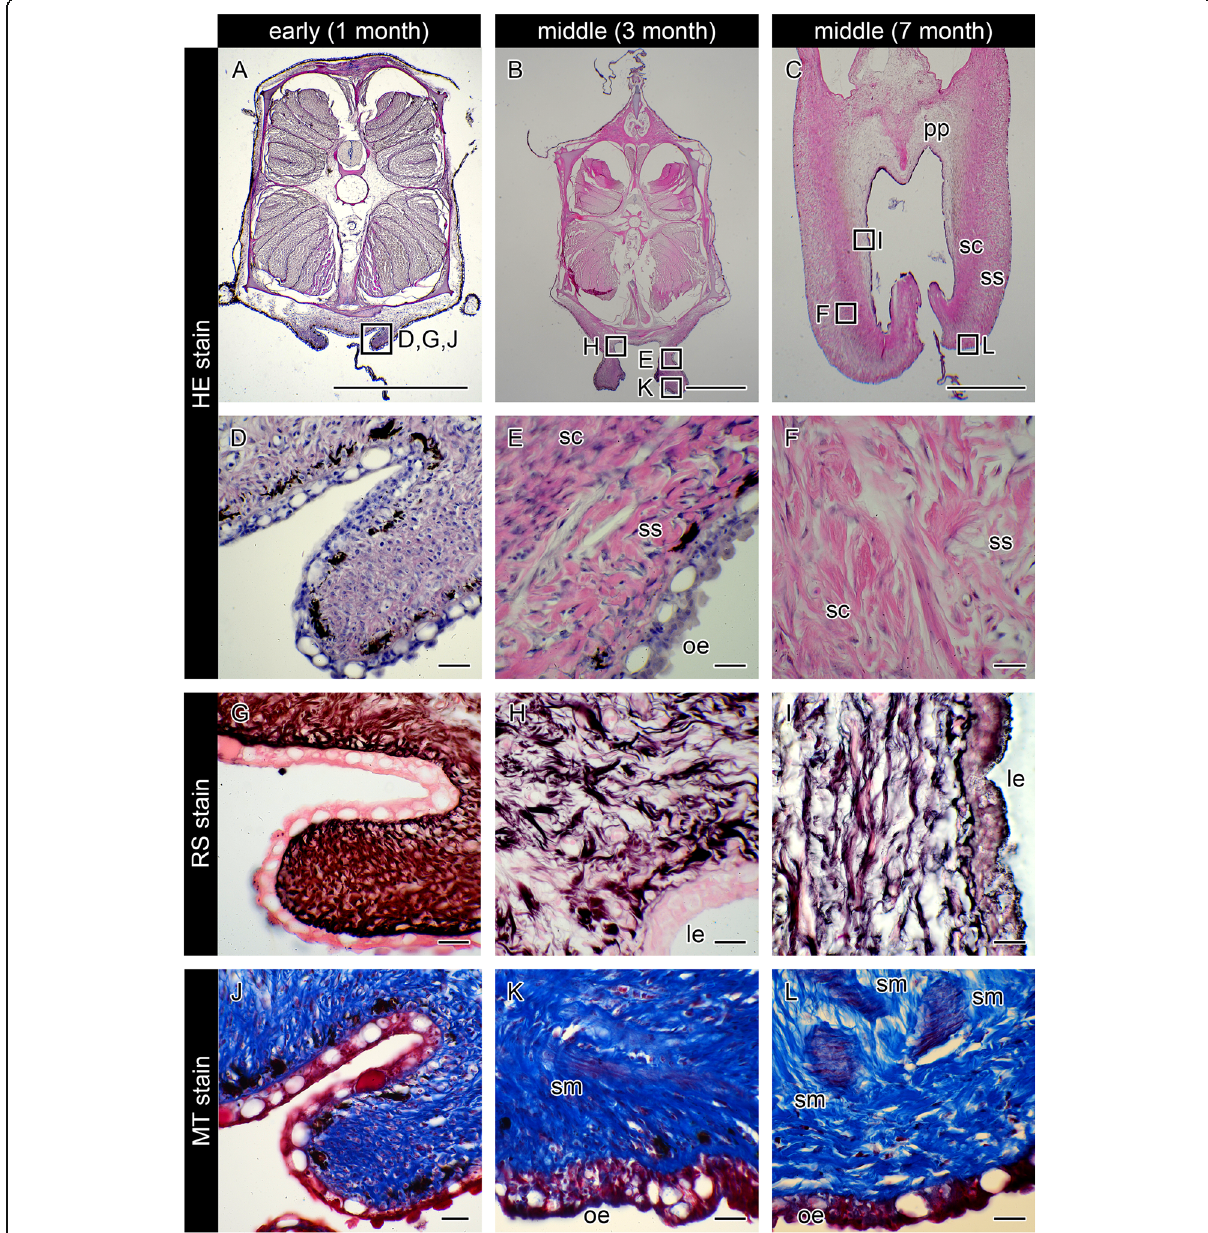
Fig. 4 Histological observations of seahorse brood pouch formation. Cross-sections of the brood pouch were observed by various staining methods: hematoxylin and eosin (HE) stain ( a – f ), reticulin silver (RS) stain ( g – i ), and Masson ’ s trichrome (MT) stain ( j – l ). These photographs show three individual males: one specimen for a , d , g , j , at 20 – 30 days after birth, showing the Y-shaped seam line (the same individual as in Fig. 3 d ); one specimen for b , e , h , k , at three months after birth; and one specimen for c , f , i , l , at seven months after birth. The lettered boxes in a – c indicate the corresponding sites of high-magnification views shown in d – l . Scale bars: a – c = 1 mm; d – l = 20 μ m. le, luminal epithelium; oe, outer epithelium; pp, pseudoplacenta; sc, stratum compactum; sm, smooth muscle; ss, stratum